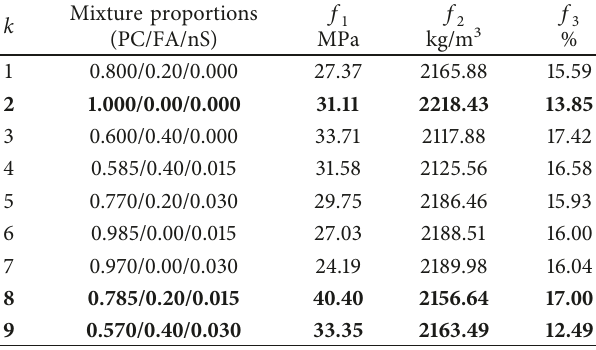
Table 9: Mixtures in bold belong to the Pareto-efficient frontier for day 7. Mixture proportions k